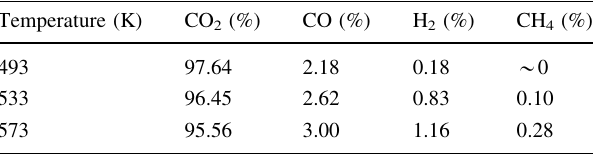
Table 3 Composition of the gas produced during the hydrothermal treatment Temperature (K)